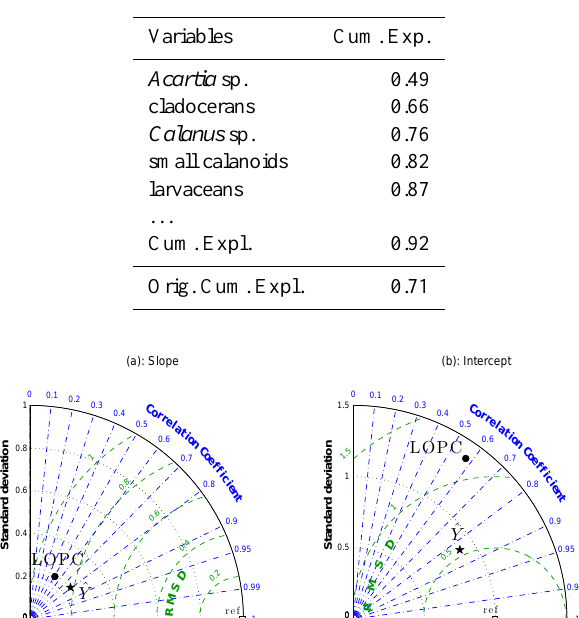
Table 4. Same as Table 3 with zooplankton group abundances from PELGAS 2009, 2010 and 2011 as explanatory variables (total of 75 stations).